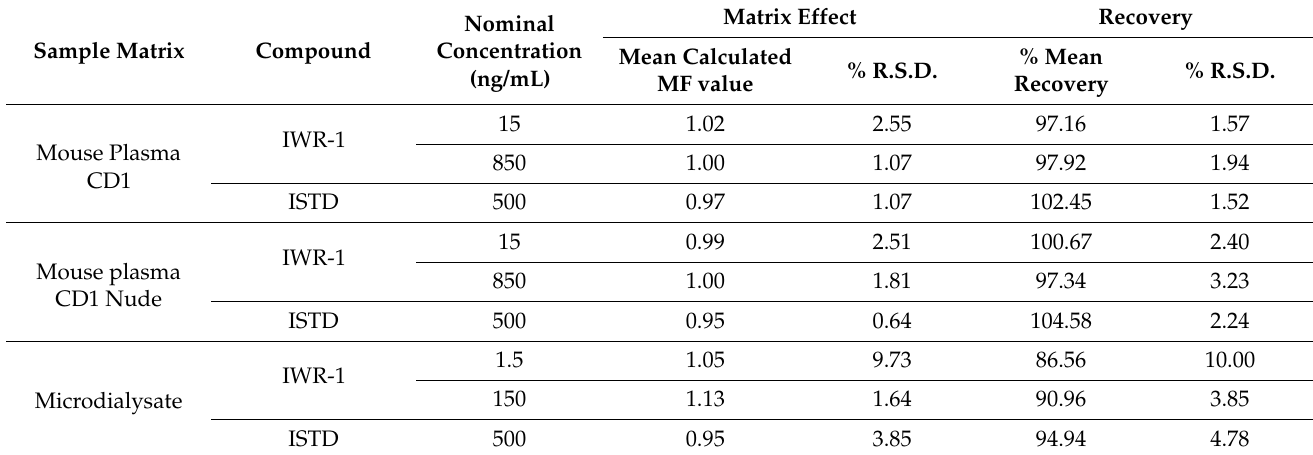
Table 4. Matrix factors and recovery in various matrices (n = 3).